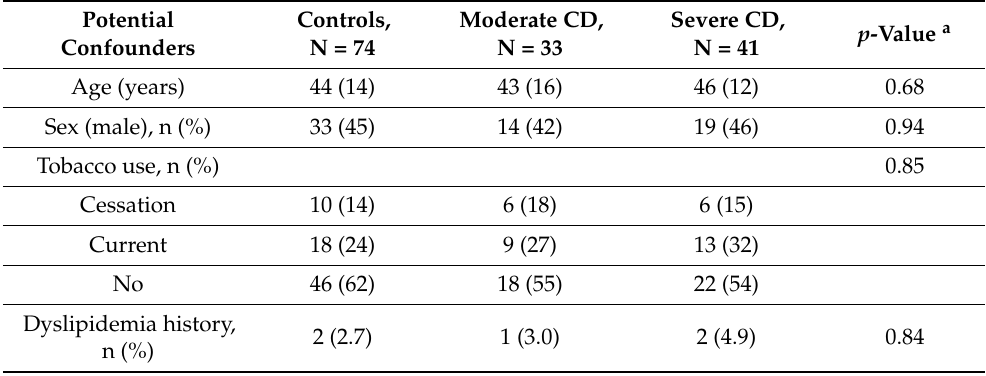
Table 2. Characteristics of patients with Crohn’s